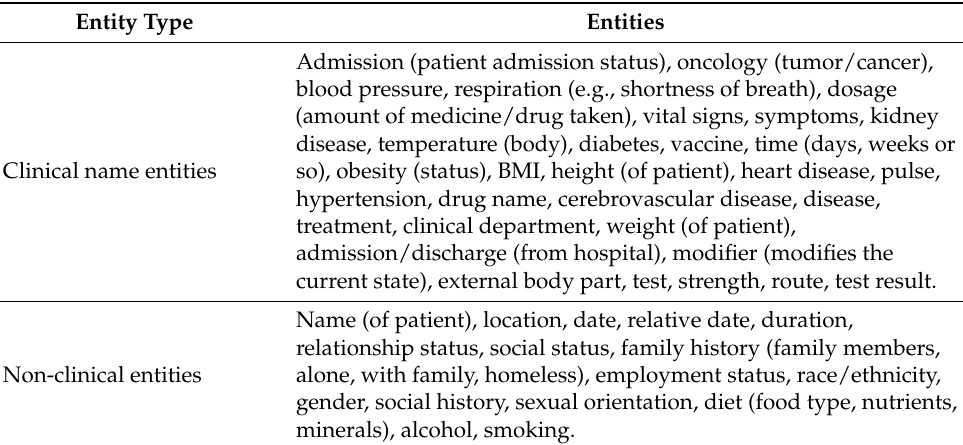
Table 2. Biomedical entities used in this